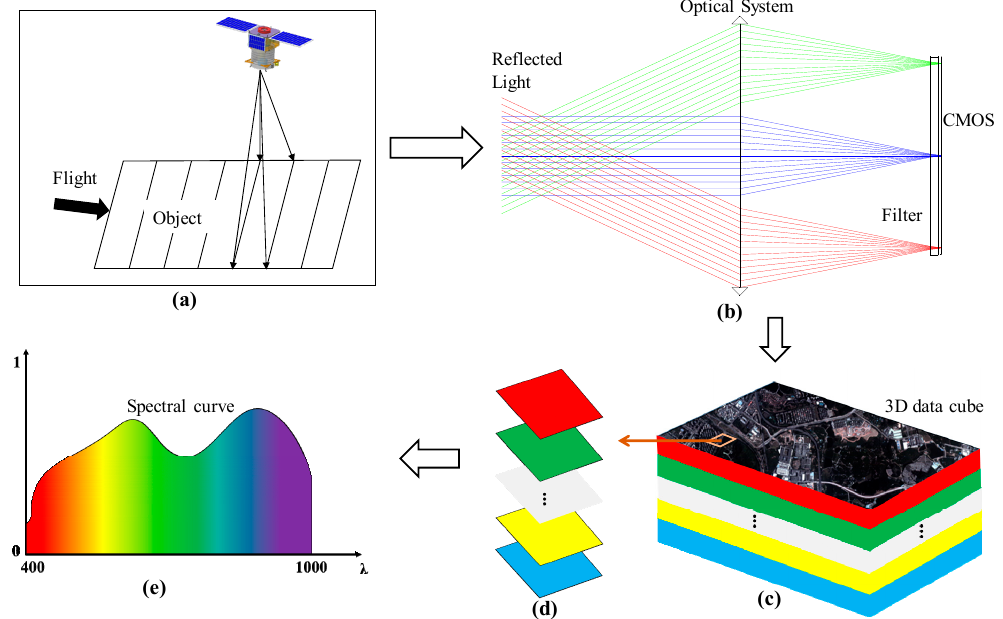
Figure 1. Schematic diagram of the imaging spectrometer’s optical system and its push-broom imaging principle. ( a ) Push-broom imaging principle, ( b ) Structure of the imaging spectrometer, ( c ) Three-dimensional data cube, ( d ) Data column in the data cube, ( e ) Spectrum curve of the ob- ject.